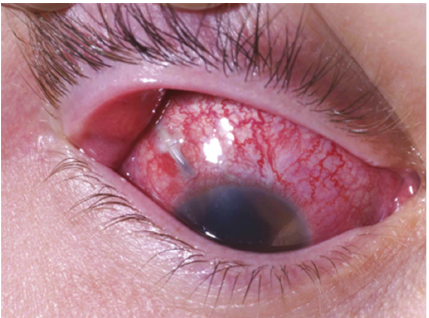
Figure 1: Right eye at 4 years of age showing congenital ectropion uvea 360 ◦ around the pupil extending partially and irregularly onto the iris surface.